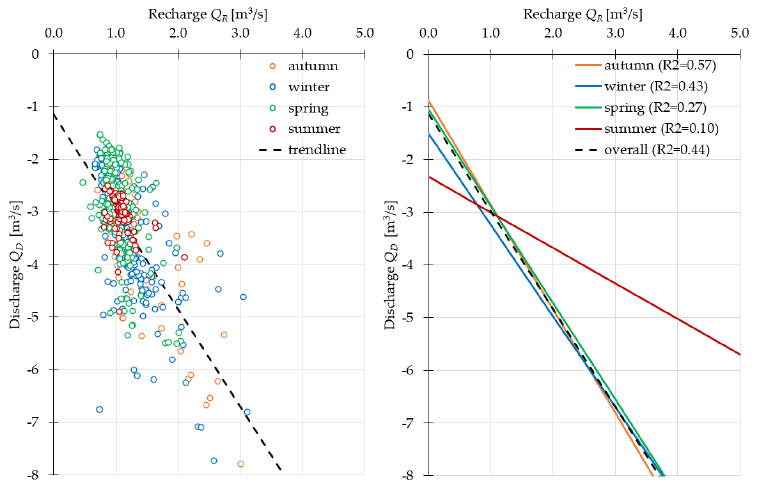
Figure 7. Scatterplot of recharge and discharge data pairs during rainfall events.